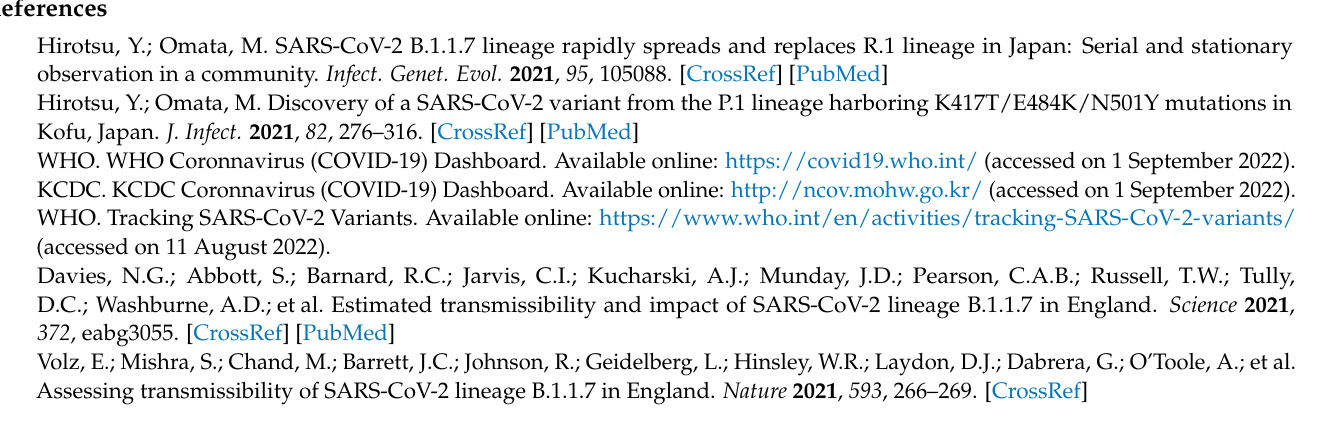
Table S6. Major spike mutations of Omicron (BA.1.1) variants of concern found in the encoded proteins of SARS-CoV-2 strains. Table S7. Major spike mutations of Omicron (BA.2) variants of concern found in the encoded proteins of SARS-CoV-2